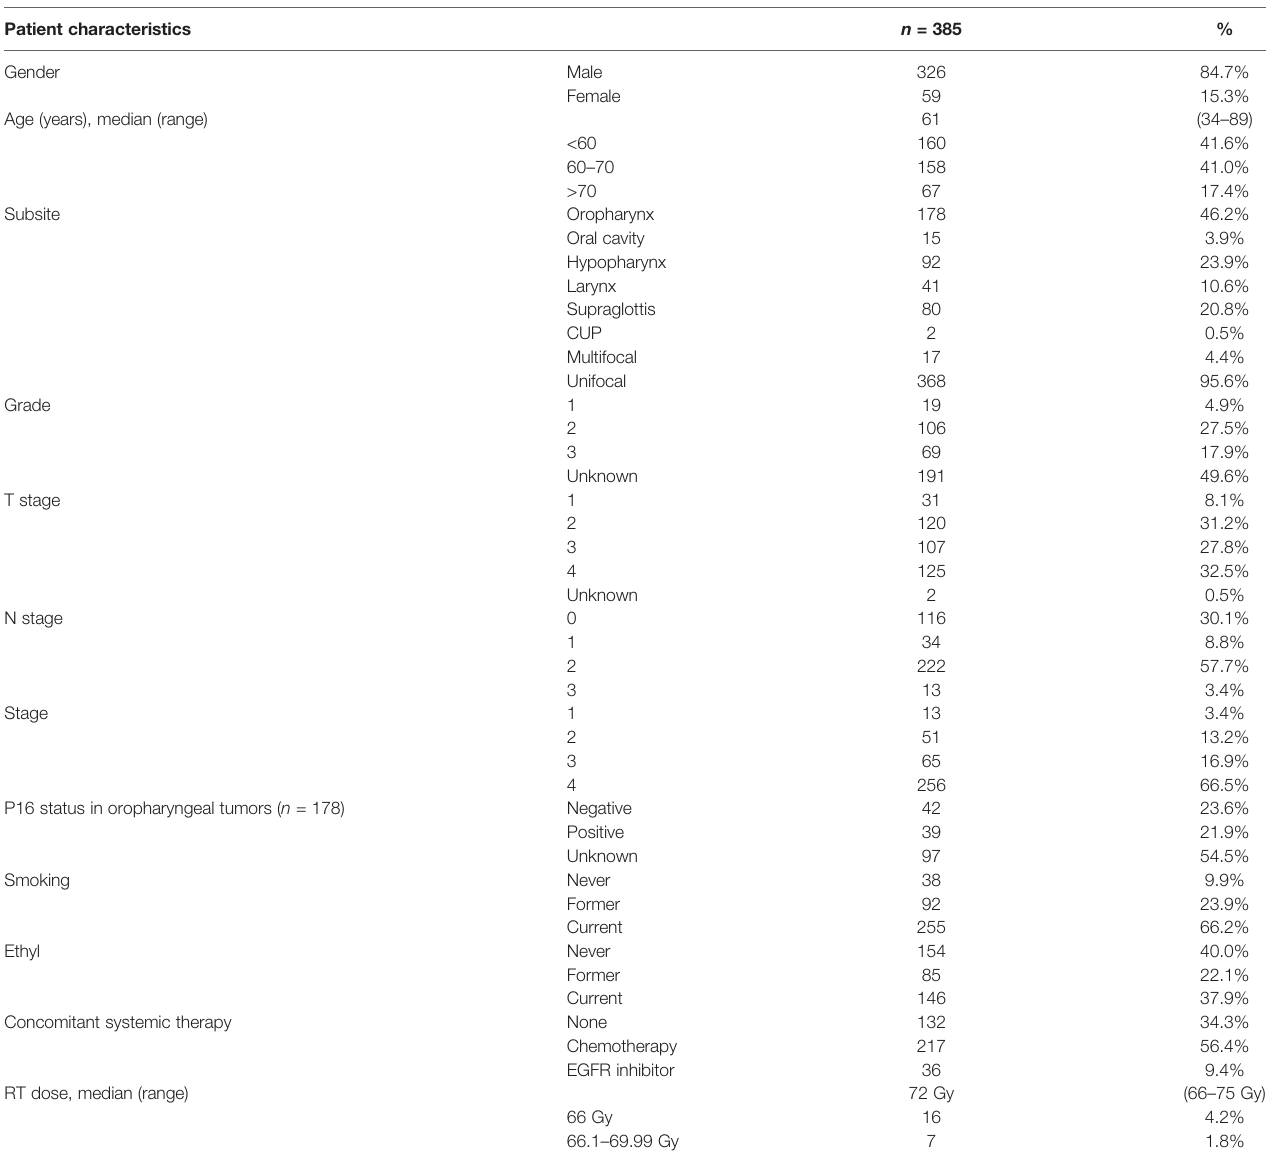
TABLE 1 | Patient